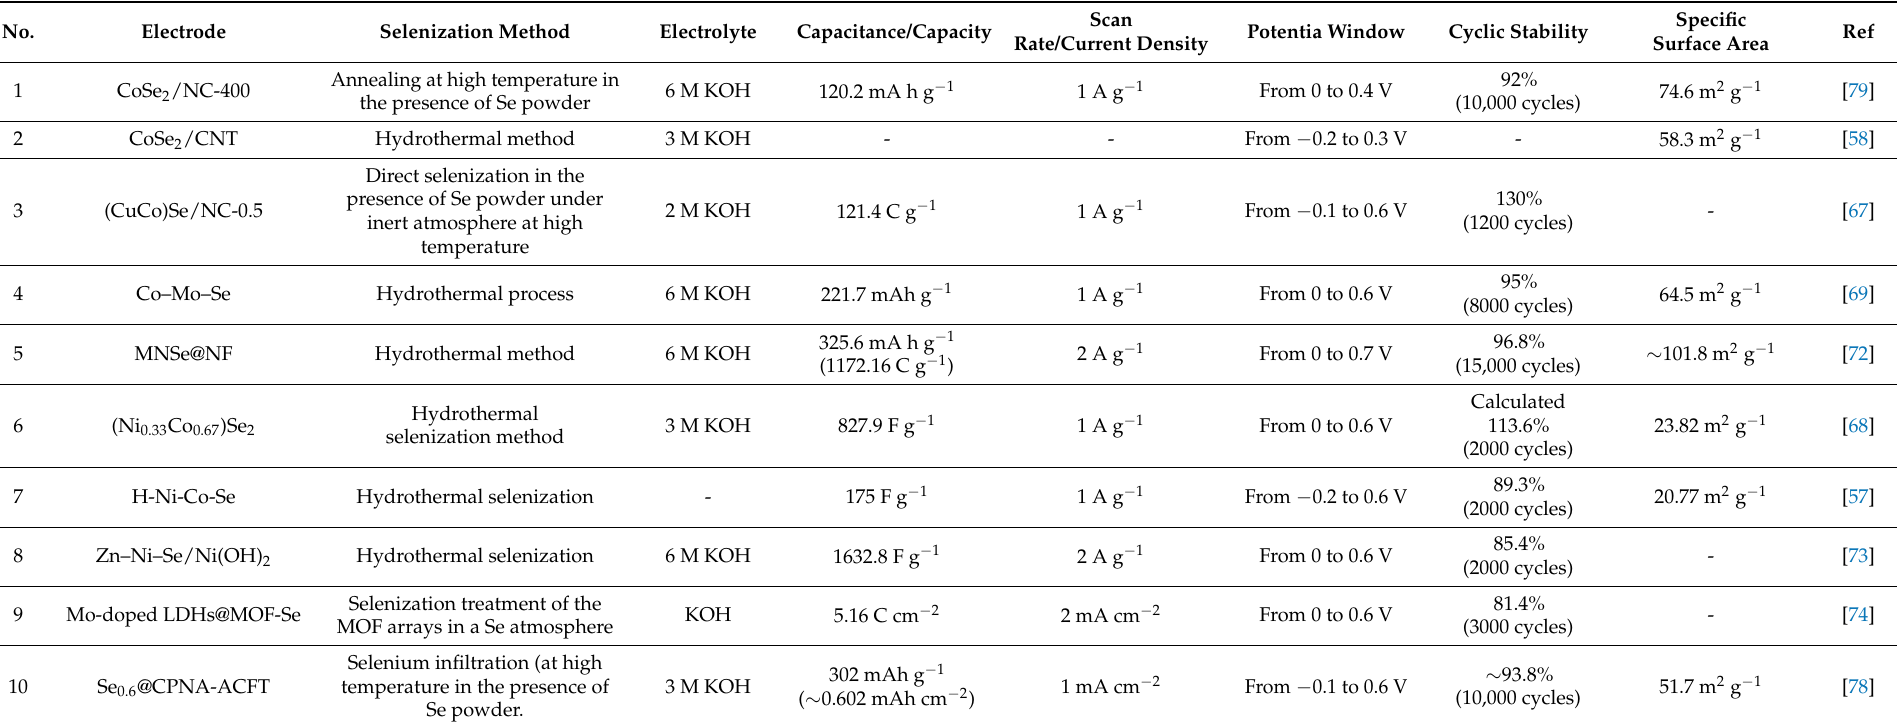
Table 3. Summary of the electrochemical parameters of the selenization-treated MOF-based electrodes in three-electrode measurement systems for supercapaci- tor